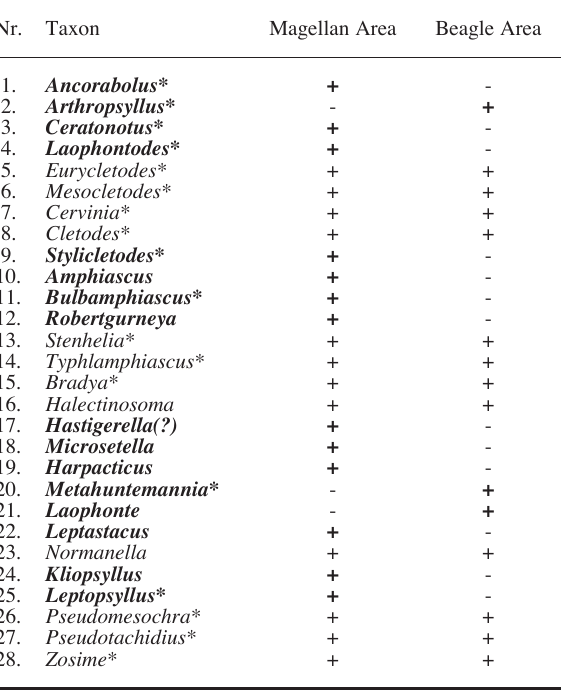
T ABLE 4. – List of harpacticoid families collected in the Magellan Straits/Beagle Channel and the Laptev Sea/Barents Sea, respective- ly. Presences marked with +, absences marked with -. Taxa restrict- ed to one of the regions indicated by bold names and symbols. Data of the Laptev and Barents Sea after P. Martínez,